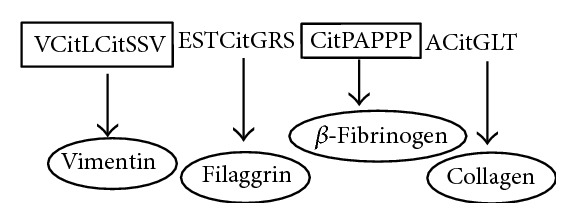
Scheme of Cit-ME peptide. Representative scheme of the multiepitope citrullinated peptide sequence delineated from the major autoantigens of anticitrullinated protein antibody (ACPA). The citrullinated residues are indicated (Cit).